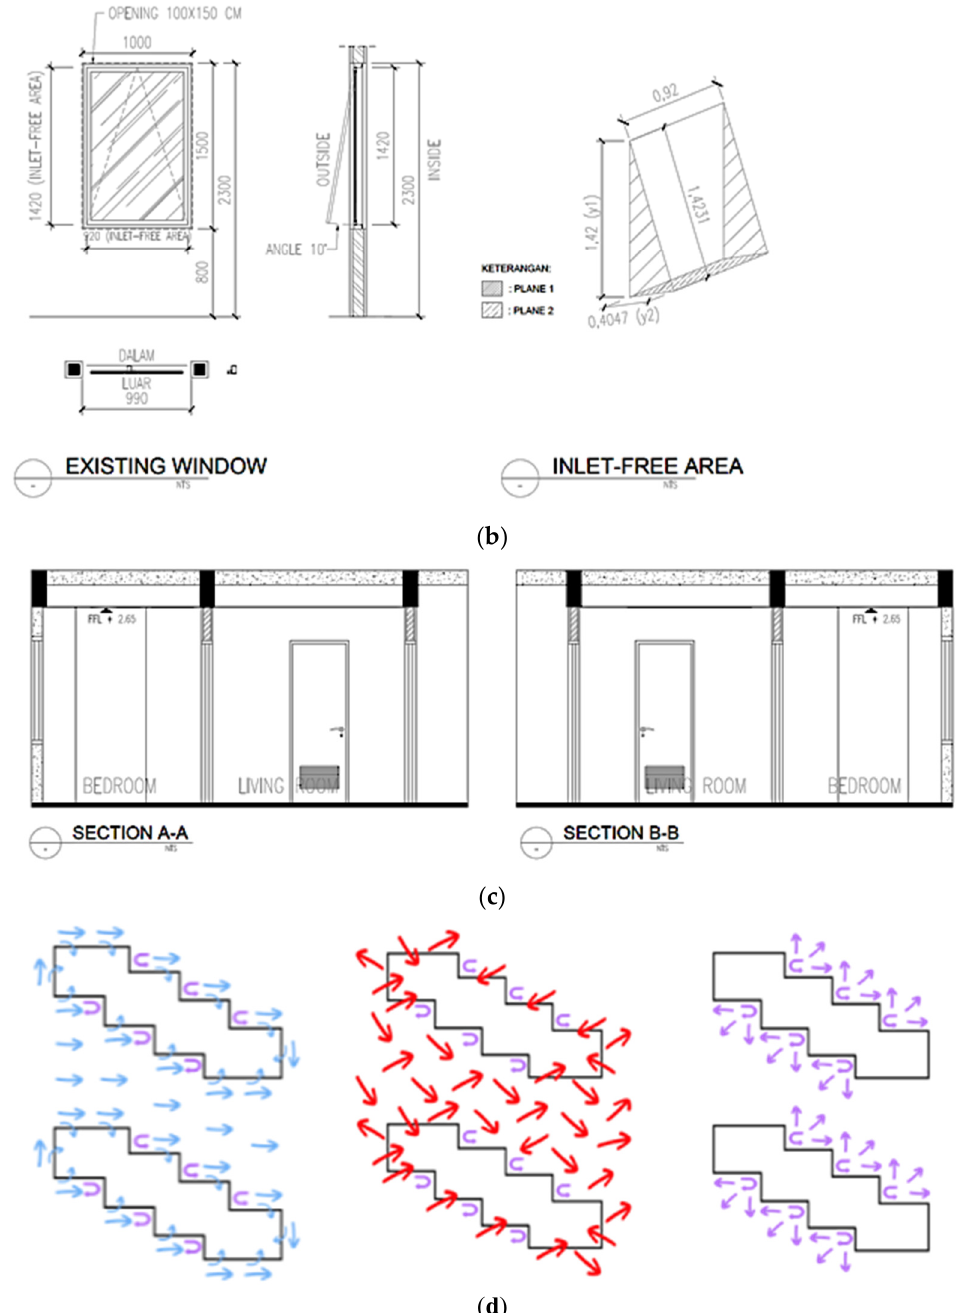
Figure 2. General data for the Jatinegara Barat flats: ( a ) residential unit plan (30 m 2 /unit); ( b ) existing windows and inlet-free areas; ( c ) residential unit sections; ( d ) illustration of the air velocity around the Jatinegara Barat flats (inspired by the basic theories of Szokolay, DeKay, and Boutet [36–38]). The variables used in this study of window dimensions were the actual air velocity, measured residential unit elevation, existing residential units, existing window dimensions, alternative window dimensions, dominant wind direction over 3 years (Figure 3), existing temperature of the residential units, and existing humidity of the residential units. The mathematical calculations used all variables, divided into two parts (as discussed in the method description). In contrast, the simulation experiments used the variables of the actual air velocity, dominant wind direction, existing residential units, dimensions of existing windows, and dimensions of alternative windows.